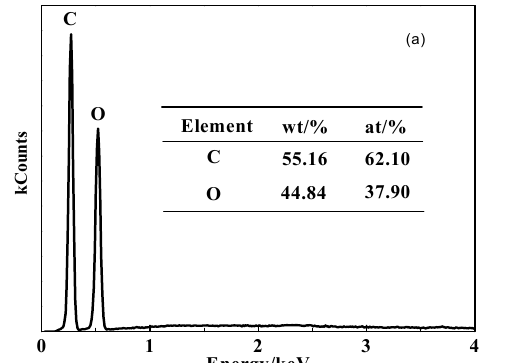
The micro-morphologies of (a) DG and (b) MDG were observed using SEM (Figure 7). It can be seen that the morphology of DG showed obvious change before and after the